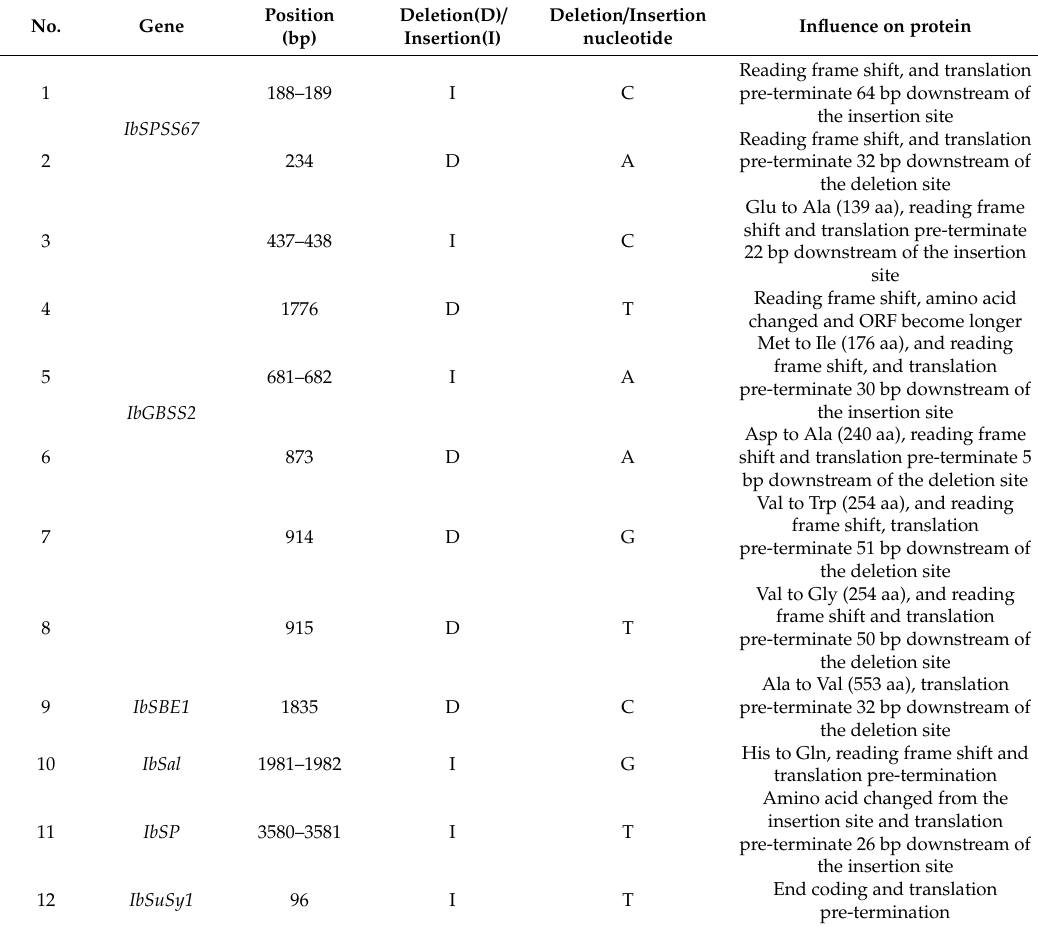
Table 3. Frameshift InDels detected in the 20 gene